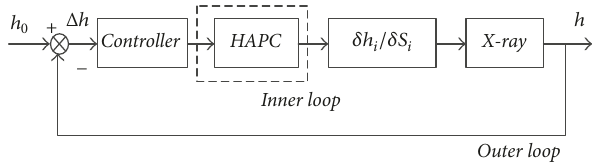
Figure 3: Block diagram of the monitoring AGC